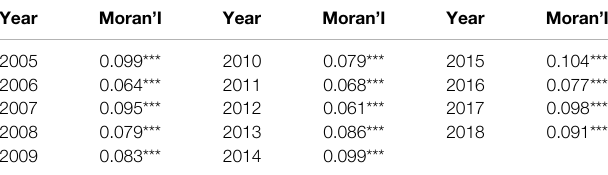
TABLE 6 | Global Moran ’ s I of PM2.5